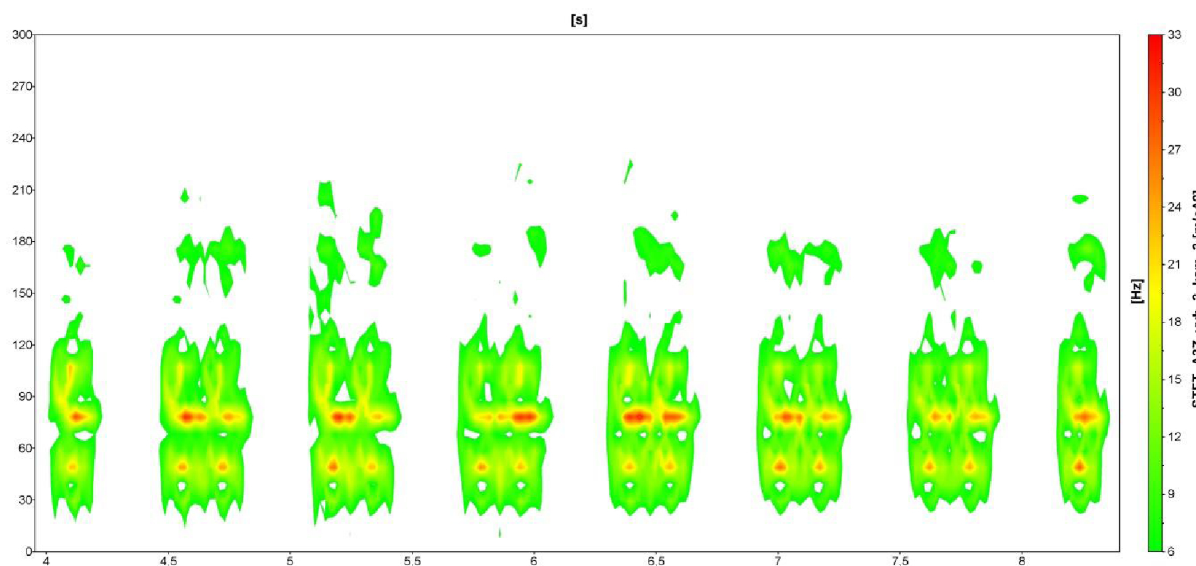
Figure 5. Time-frequency spectrogram calculated by STFT method, turnout no. 3, Pendolino train, third measurement